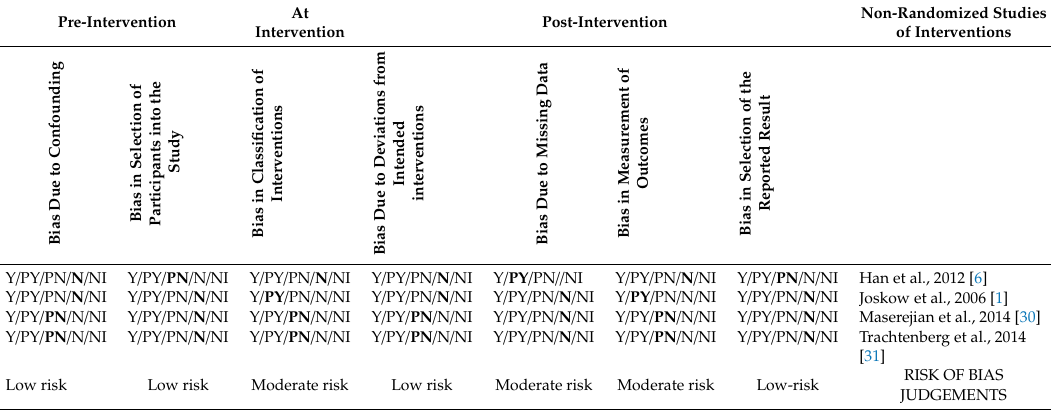
Table 3. Evaluation of quality assessment of non-randomized studies of the systematic review. Pre-Intervention At Intervention Post-Intervention Non-Randomized Studies of Interventions